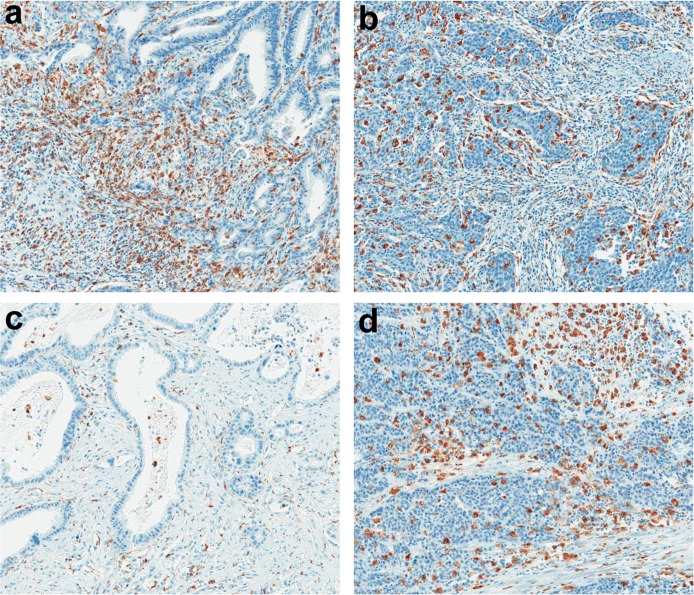
Density of CD68+ TAMs (a) stromahigh/epitheliumlow, (b) stromalow/epitheliumhigh, (c) stromalow/epitheliumlow and (d) stromahigh/epitheliumhigh.